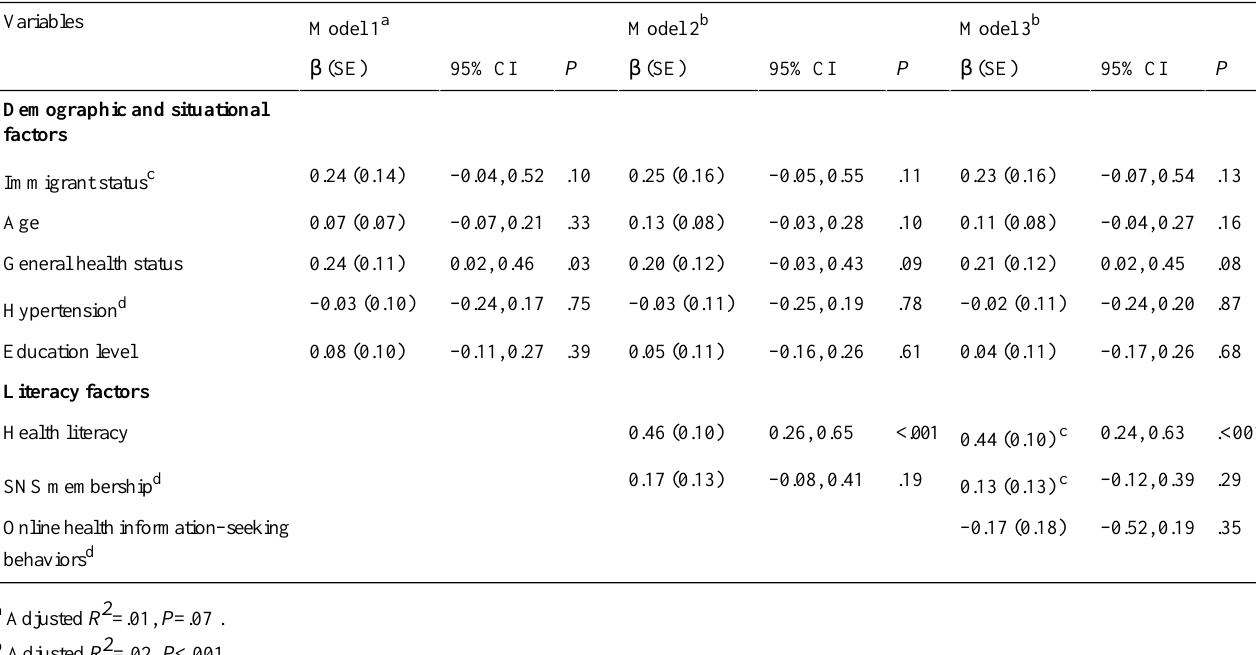
Table 6. Ordinal logistic regression: association between online health information–seeking behaviors and alcohol consumption.